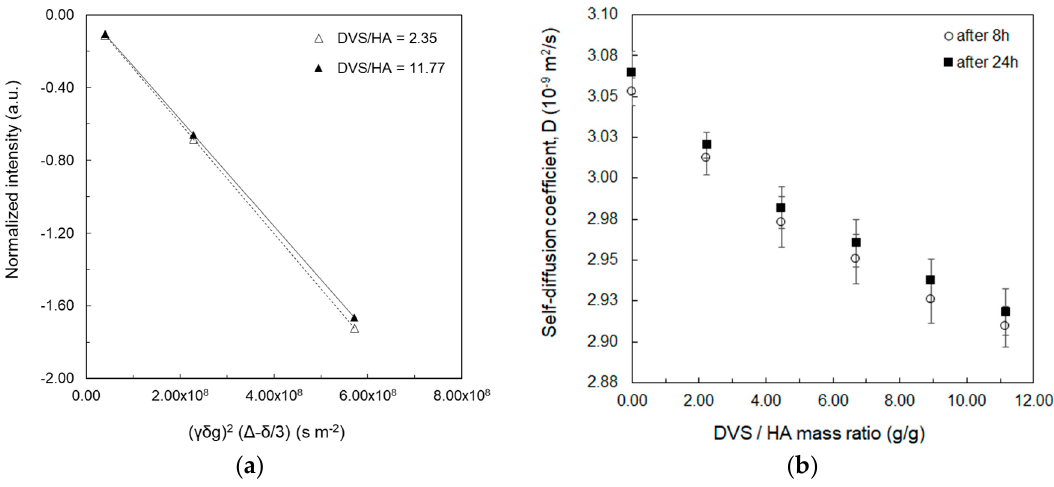
Figure 1. Di ff usion measurements at 20 MHz: ( a ) Stejskal-Tanner plot to calculate water self-di ff usion coe ffi cient of 0.25% w / v HA crosslinked with DVS at 2.35 (empty triangles) and 11.77 (filled triangles) DVS / HA mass ratio after 8 h from the addition of the crosslinker; ( b ) Self-di ff usion coe ffi cient as a function of DVS / HA mass ratio measured after 8 h (empty circles) and 24 h (filled squares) from the addition of the